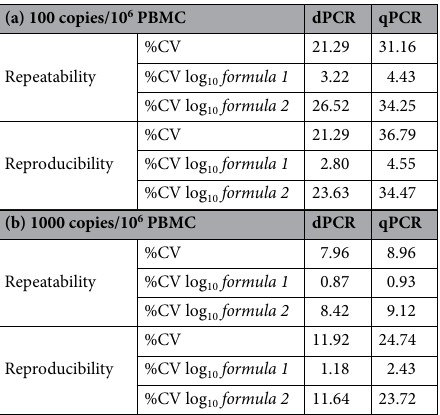
Table 2. Precision experiments to compare the dPCR and qPCR methods with the coefficient of variation (CV%). For the two concentrations, ( a ) 100 copies/10 6 PBMC and ( b ) 1000 copies/10 6 PBMC, the tables show the results of the repeatability and reproducibility studies in CV% in normal and log-transformed data calculated with the formula 1 = σ/µ and the CV% of log-transformed data calculated with the formula 2 = (cid:31) e σ 2 − 1 . Formula 1 is commonly used to calculate the CV of untransformed data, and formula 2 the CV of log-transformed data. The CV calculation with formula 1 is often used in the literature. However, with a serious statistical error, Formula 1 is not correct for calculating the coefficient of variation of log- transformed data because the mean μ depends on the unit.